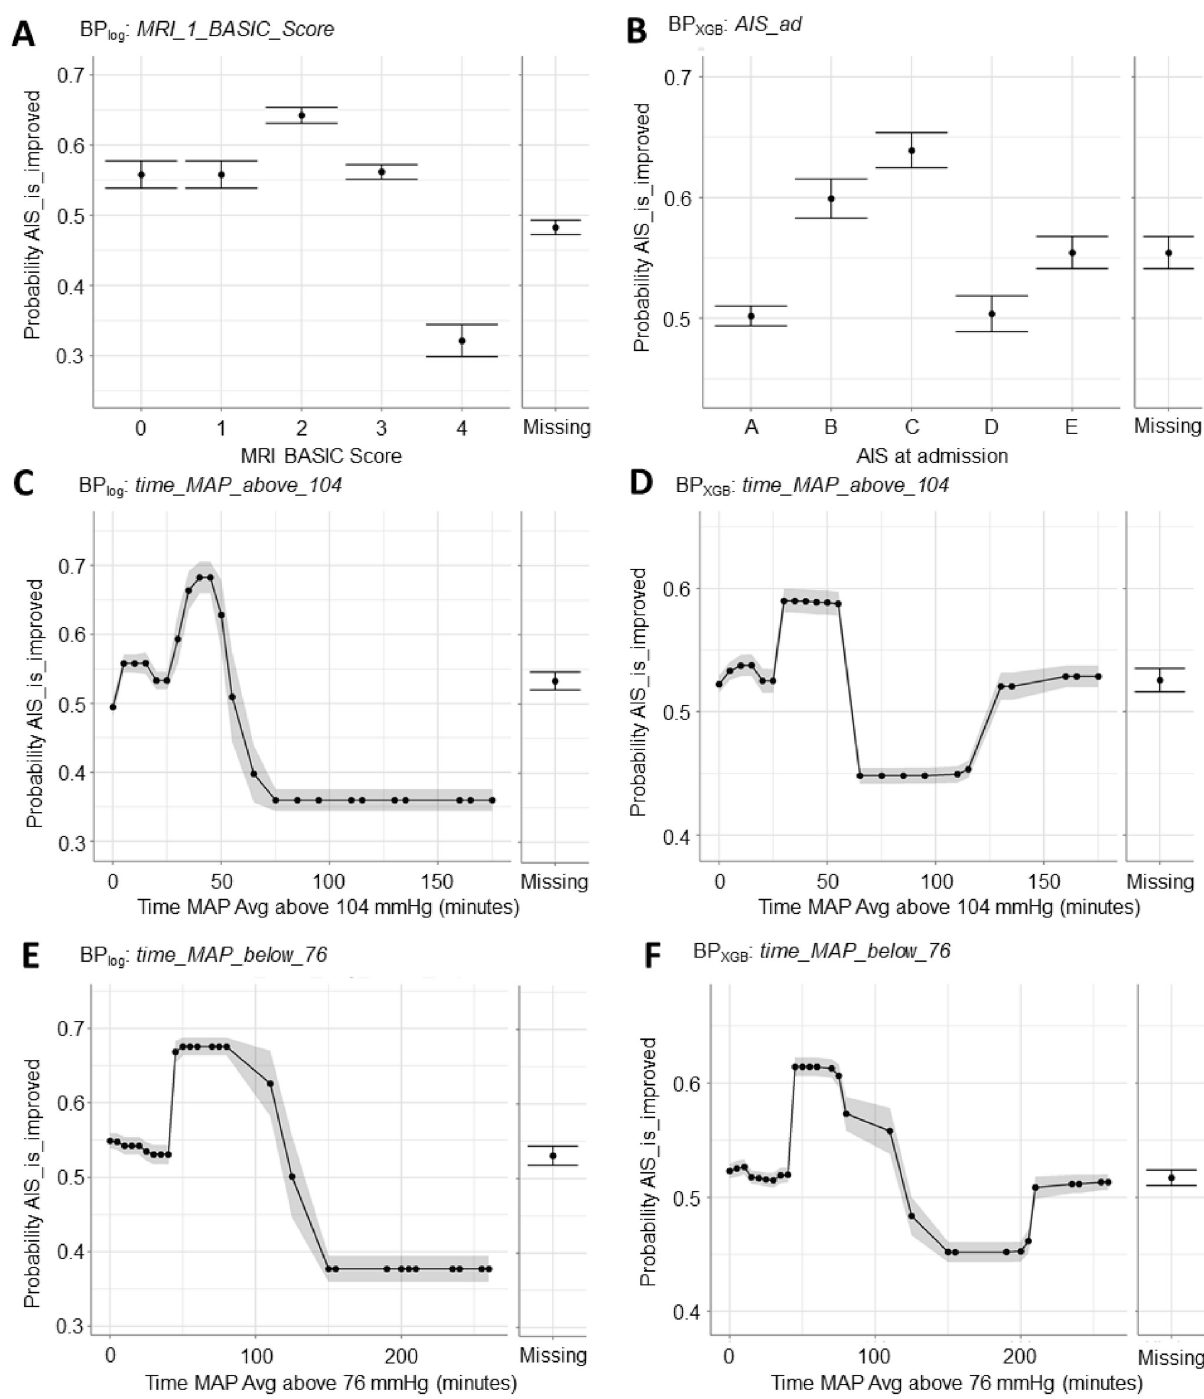
Fig 5. Partial dependence plots (PDPs) for features of interest help interpret how features affect model prediction of BP log and BP XGB . (A) For BP log , an MRI BASIC score of 4 resulted in lower prediction of improved outcome. A MRI BASIC score of 0–3 increased prediction of better outcome with a MRI BASIC score of 2 leading to the highest probability of improvement. (B) For BP XGB , an AIS score of A or D at admission resulted in lower probability of patient improvement. AIS scores of B and C both led to higher probability of improvement with AIS score C resulting in the highest probability. (C) For BP log and (D) BP XGB , if a patient’s MAP exceeded an upper threshold of 104 mmHg for more than 50–75 minutes, the predicted probability of improvement decreased significantly. (E) For BP log and (F) BP XGB , if a patient’s MAP fell below a lower threshold of 76 mmHg for more than 100–150 minutes, the predicted probability of improvement decreased significantly. Notably, BP XGB PDP for both time_MAP_Avg_above_104 and time_MAP_Avg_below_76 exhibited a rebound in predicted improvement probability at extreme upper values that was absent on the BP log PDPs.